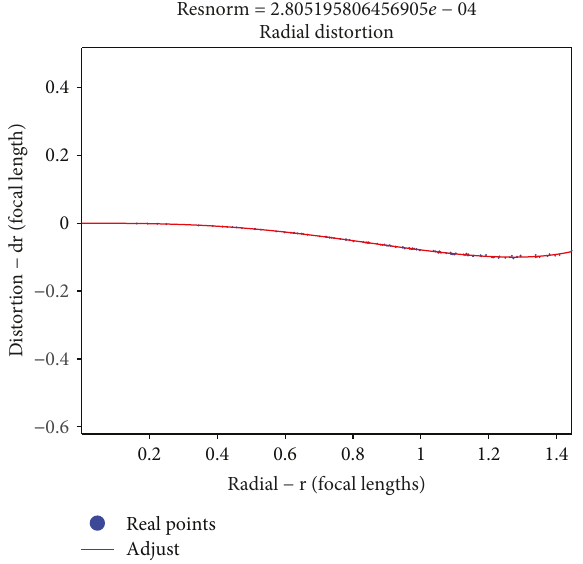
Figure 21: Radial distortion curve obtained in the IPEV fi eld, considering the pod rear camera.